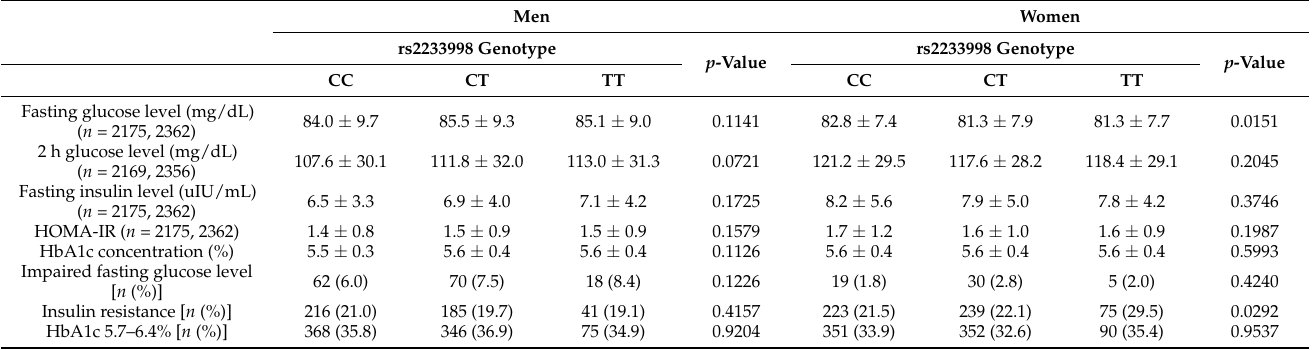
Table 3. Clinical characteristics of the participants at baseline according to TAS2R4 rs2233998 genotype. Men